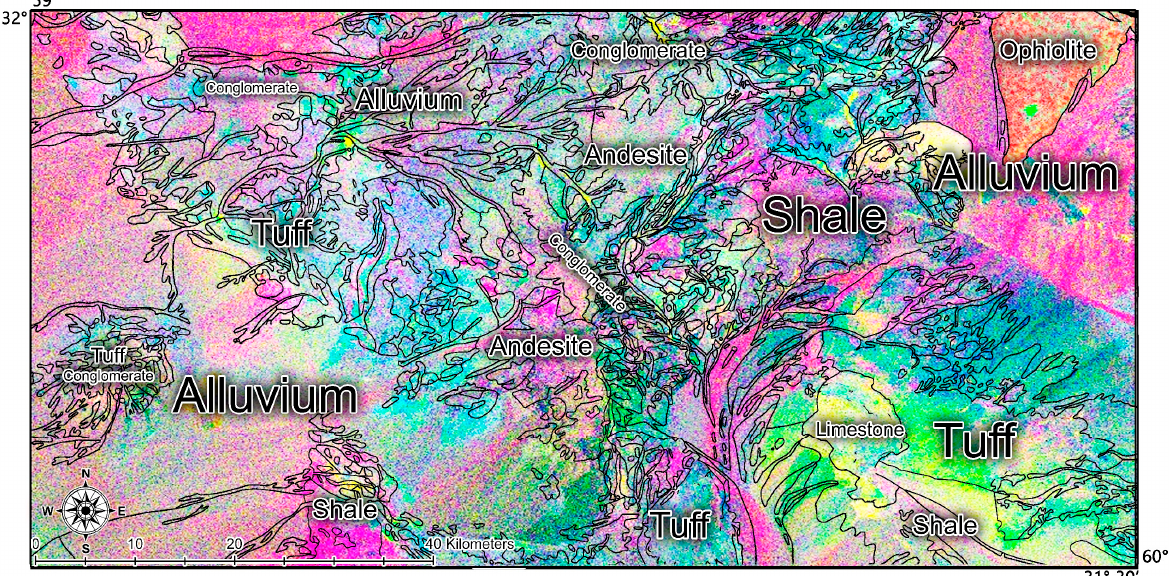
Figure 7. The image resulting from the false color combination of − R7, R4 and R3 residues (RGB = − R7, R4, R3) using the Ls-Fit method from the ETM + satellite sensor.